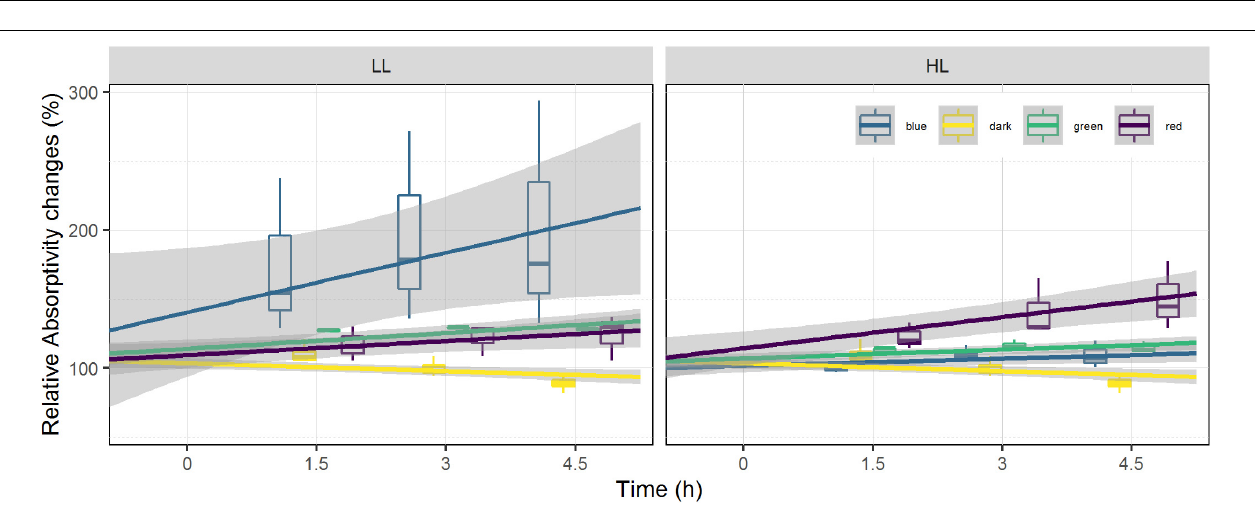
FIGURE 3 | α -slope changes for differing Qphar intensities. α -slope are displayed as percentages of the initial value prior to illumination. Qphar recalculated intensities are 63.8 (R210), 76.2 (G210), 198.3 (B210), 255.02 (R800), 305.01 (G800), and 793.29 (B800) µ mol.photons.m − 2 .s − 1 . The area below 200 µ mol.photons.m − 2 .s − 1 (yellow) correspond to non-stressful light conditions where NPQ is relaxing while the area above 250 µ mol.photons.m − 2 .s − 1 (purple) correspond to stressful light inducing NPQ. The boundary and threshold between LL Qphar and HL Qphar is represented in pink. n = 3 for each point.